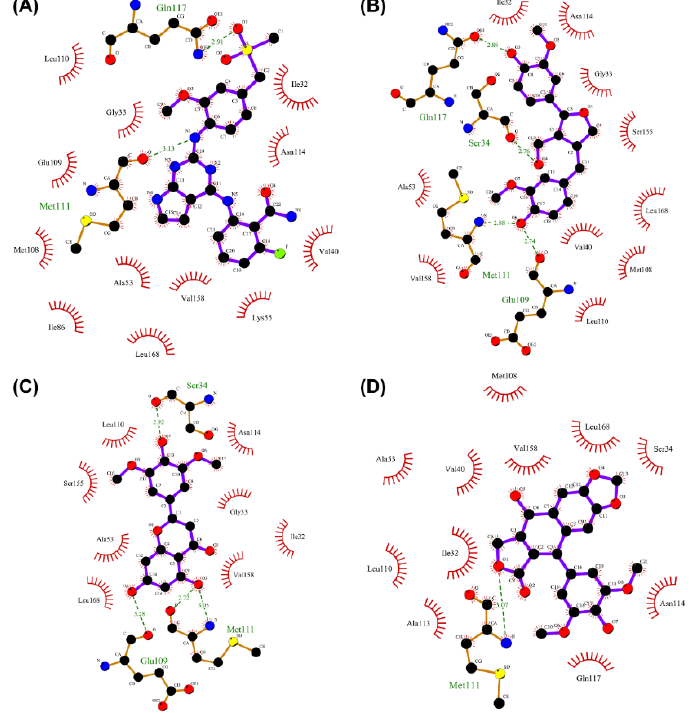
Figure 5. Two-dimensional presentations of the interactions between ligands and JNK1. ( A ) Co- crystallized ligand, ( B ) Lariciresinol, ( C ) Tricin, and ( D ) 4 ′ -Demethylepipodophyllotoxin.